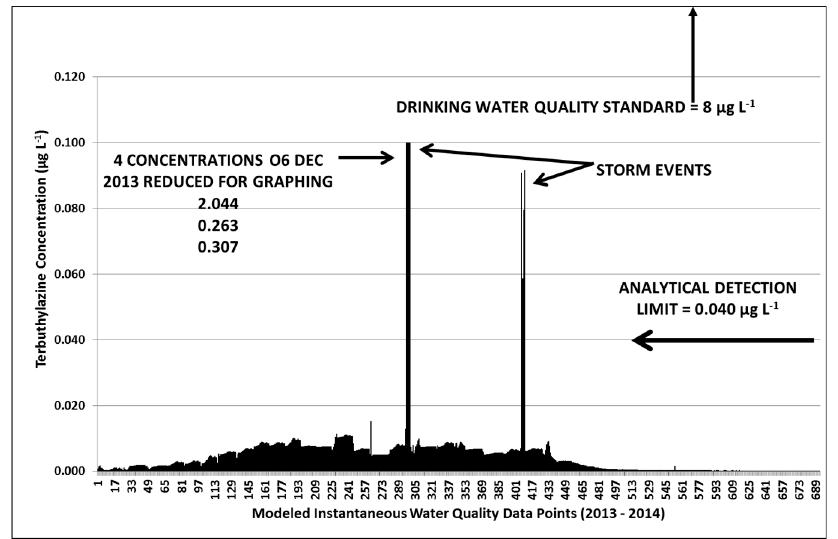
Figure 17. Year 2—modeled instantaneous concentrations of terbuthylazine in the Rangitaiki River at the Rangitaiki flow gauge.